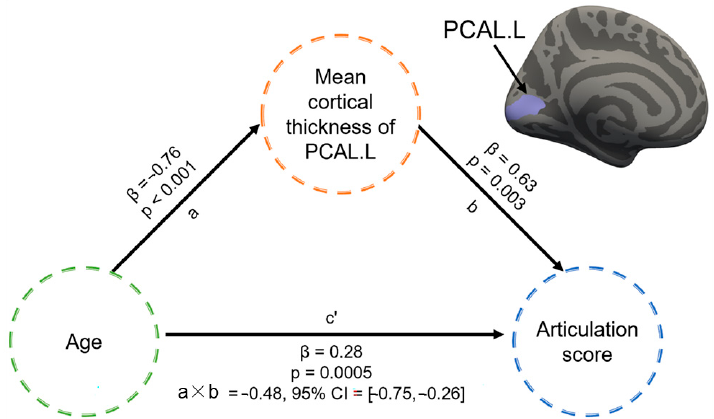
Figure 6. Significant mediation effect of the left pericalcarine cortex (PCAL.L) between age and articulation score in CLP. Path a: the relationship between age and mean cortical thickness of the PCAL.L; Path b: the relationship between mean cortical thickness of PCAL.L and the articulation performance; Path c’: the relationship between age and the measures of articulation function; Path a × b represents an indirect path, namely, the authors declare a relationship between age and articulation function, which was mediated by the mean cortical thickness of the PCAL.L. A significant mediation effect is deemed when the 95% bootstrapping confidence interval based on 10,000 bootstrap samples does not contain zero.